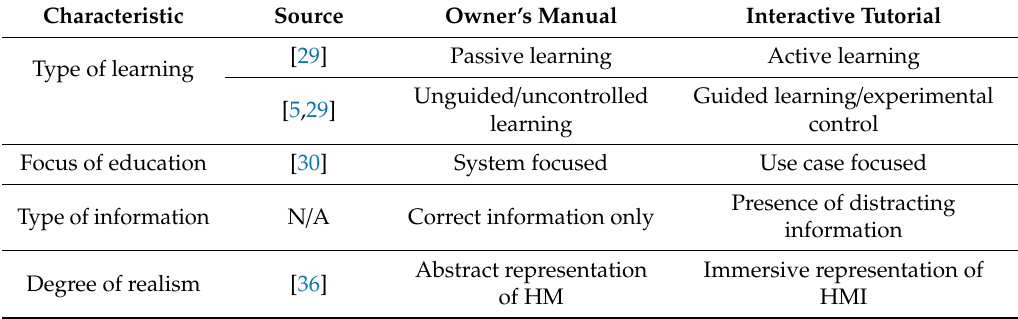
Table 1. Summary of characteristics of manual and tutorial based user education